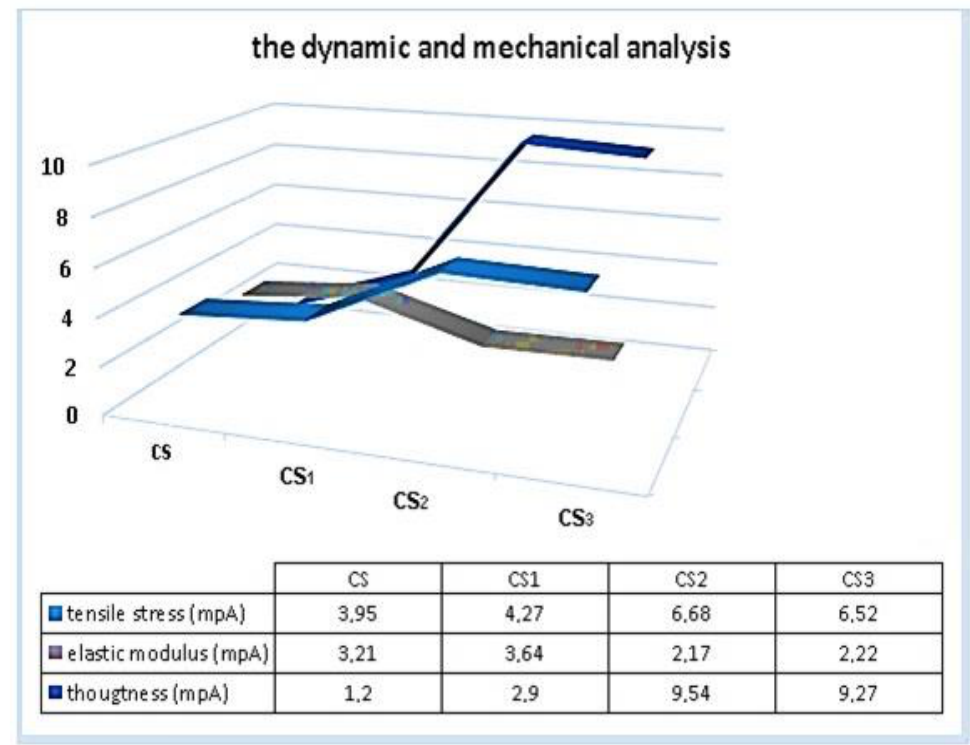
Figure 7. The tensile stress, elastic modulus and toughness analysis results of CS and CS silver